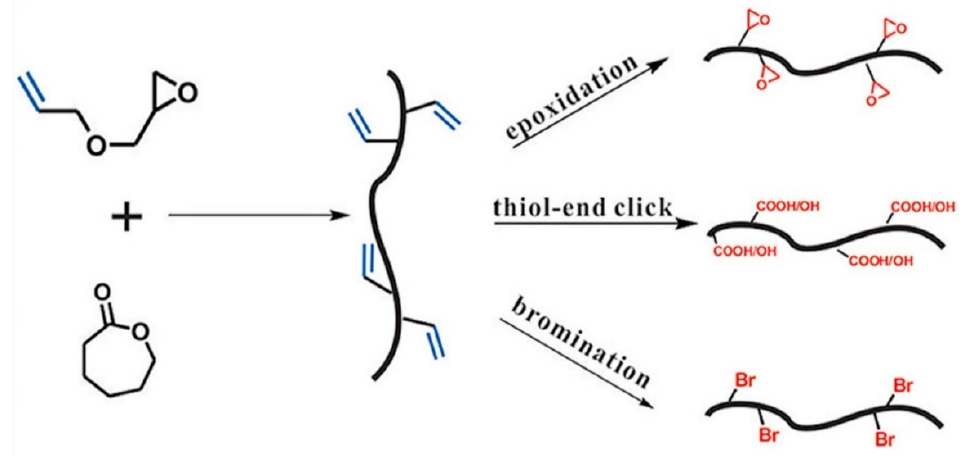
Figure 8. Schematic representation of pendant allyl groups containing poly(CL-AGE) copolymer synthesis and post-functionalization as reported by Yang et al. Reprinted with permission from [40]; Published by Elsevier, 2017.